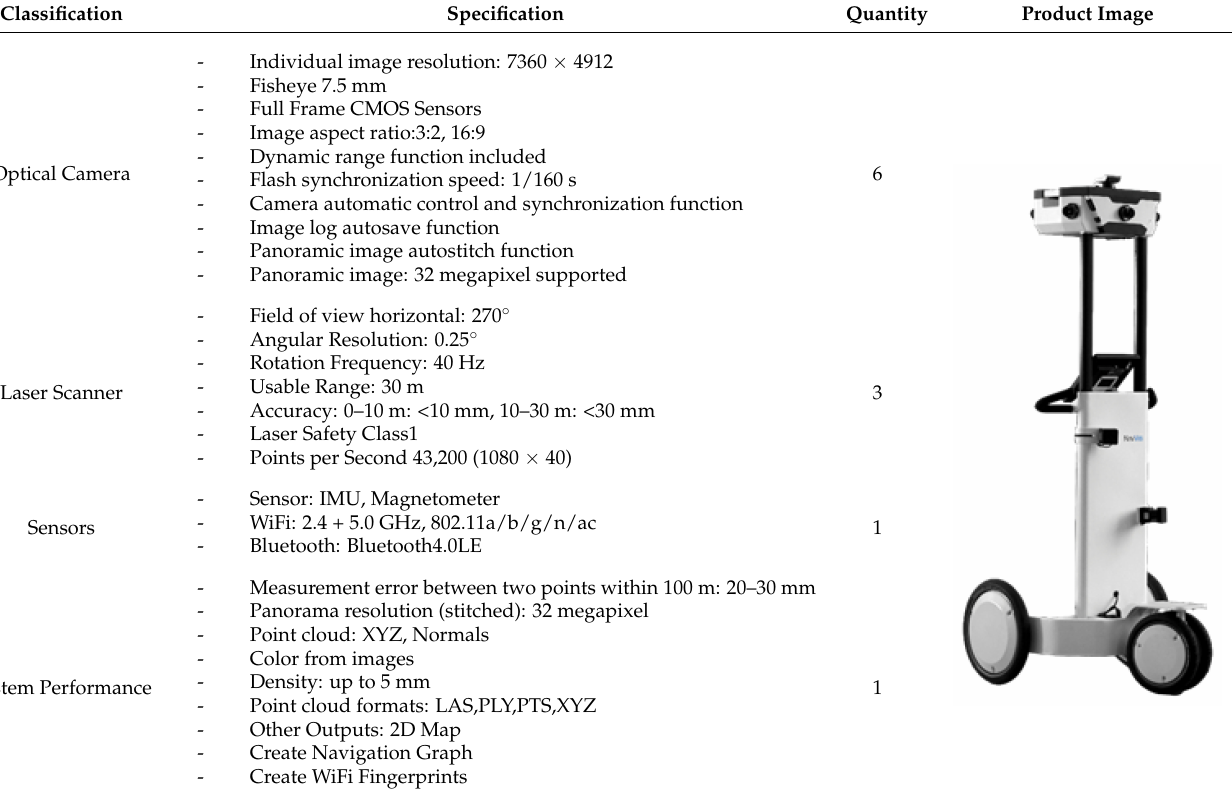
Table 2. Characteristics of used data.